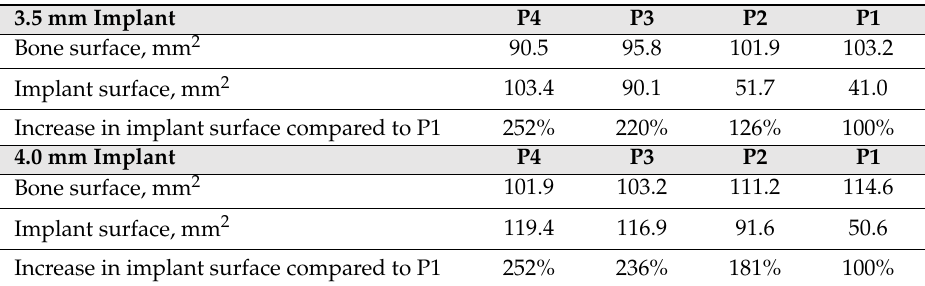
Figure 2. Surface morphology of area of the implant in contact with the bone, and the diameter in each site preparation for 3.5 mm diameter implants. Table 1. Bone surface, implant surface and % of reduction for implant surface values for 3.5 and 4.0 mm diameter implants in each